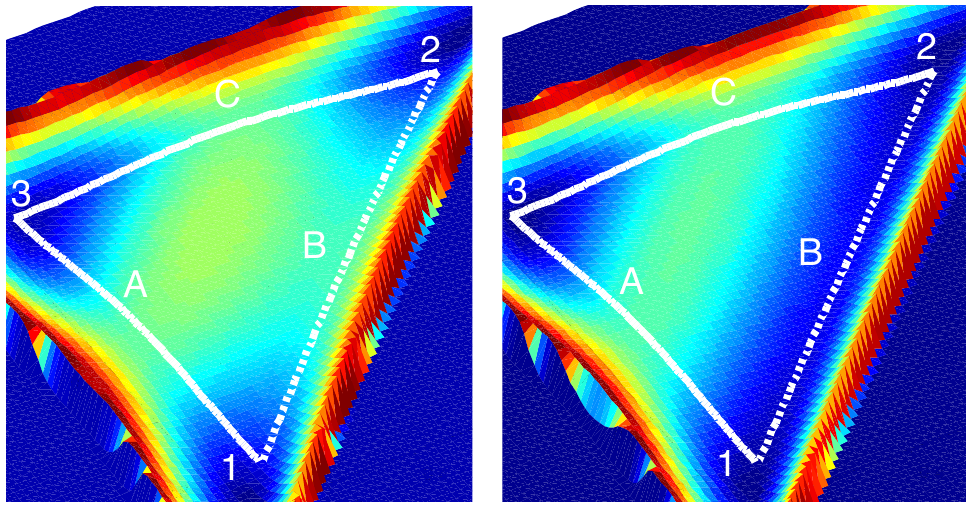
Figure 9. (Left) Surface plot of W U = ( U , U ) plane over the admissible triangle whose m in the 1 2 A corners, labeled i = 1 , 2 , 3 correspond to equilibrium states U i = 1 . The critical orbits A, B, and C correspond to critical point connections, or interfaces, between the equilibrium states. A composition dependency of η m = η m ( U ) for which η m is positive along A and negative along C renders the C interface energetically unfavorable. (Right) A high temperature form of the W m lowers the barrier between the two polymer phases, 1 and 2